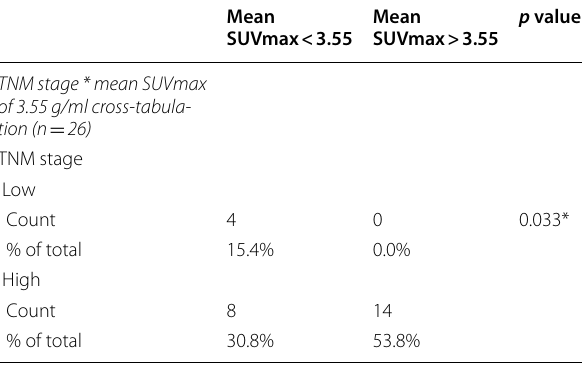
*Correlation is significant at the 0.05 level (two tailed)